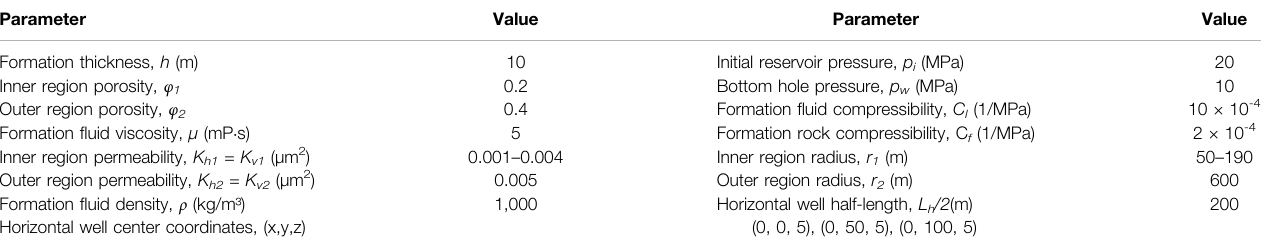
TABLE 2 | Input parameters for horizontal well passing through both inner region and outer region on both sides. Parameter